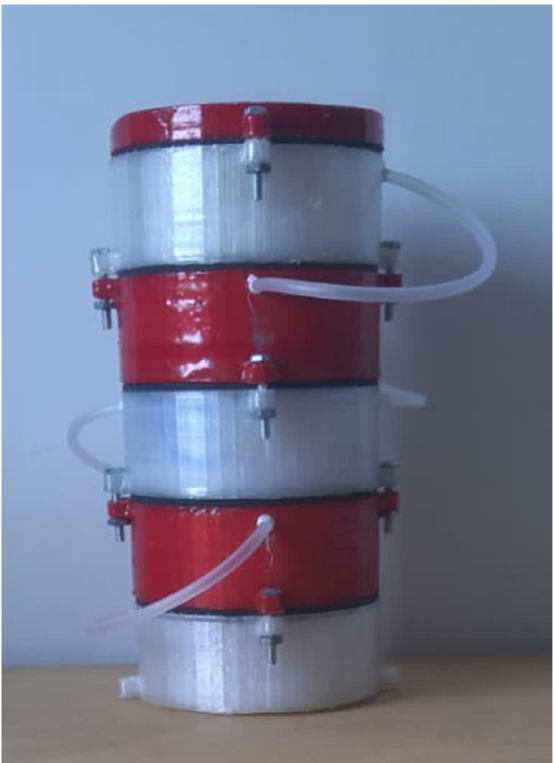
Figure 6. Overall Cascade System for Biomineralization in Cement.